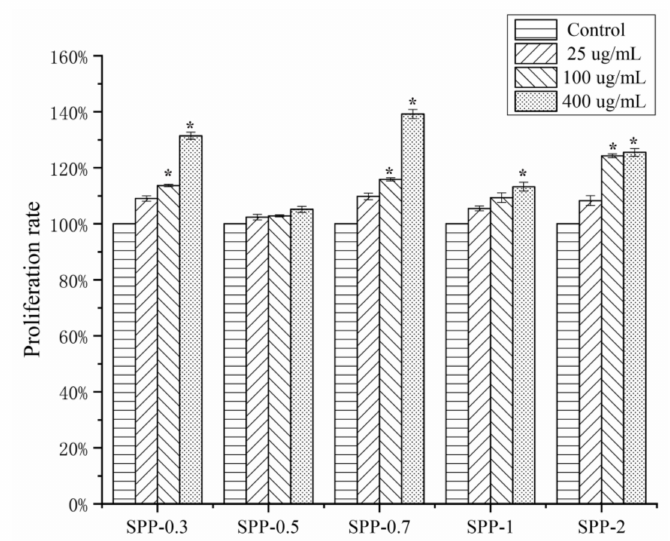
Figure 3. Effects of five polysaccharide fractions with different concentrations (25, 100, and 400 µ g/mL) on proliferation of macrophage (RAW264.7) cells (mean ± SD). The asterisk (*) on the bars indicated the significance difference ( p < 0.05) in proliferation rate between experimental group and control group according to one-way ANOVA test.